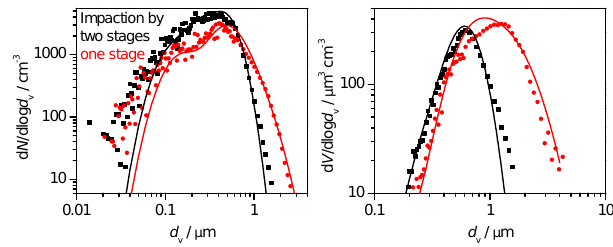
Fig. 2. Number (left panel) and volume (right panel) size distribu- tion of dispersed SAMUM B3 dust particles. The black squares and red dots denote the combined SMPS/APS measurements for exper- iments with two stages (Exp. 8, Table 1) and one stage (Exp. 9) of the cyclone impaction system, respectively. The solid lines are the optimised size distributions obtained by best fitting the simultane- ously recorded extinction spectra of the dust particles as described in Sect.